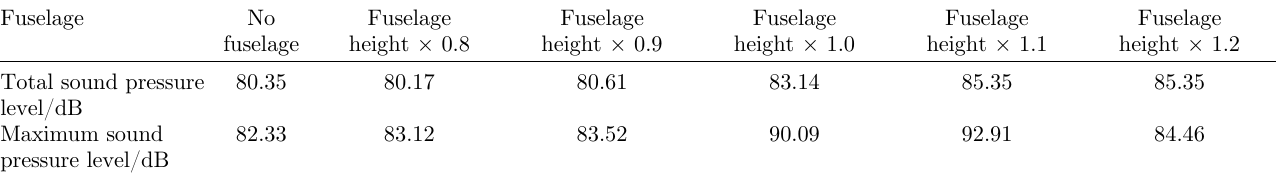
Table 7. Total and maximum SPL of helicopters with fuselages of different height ratios.